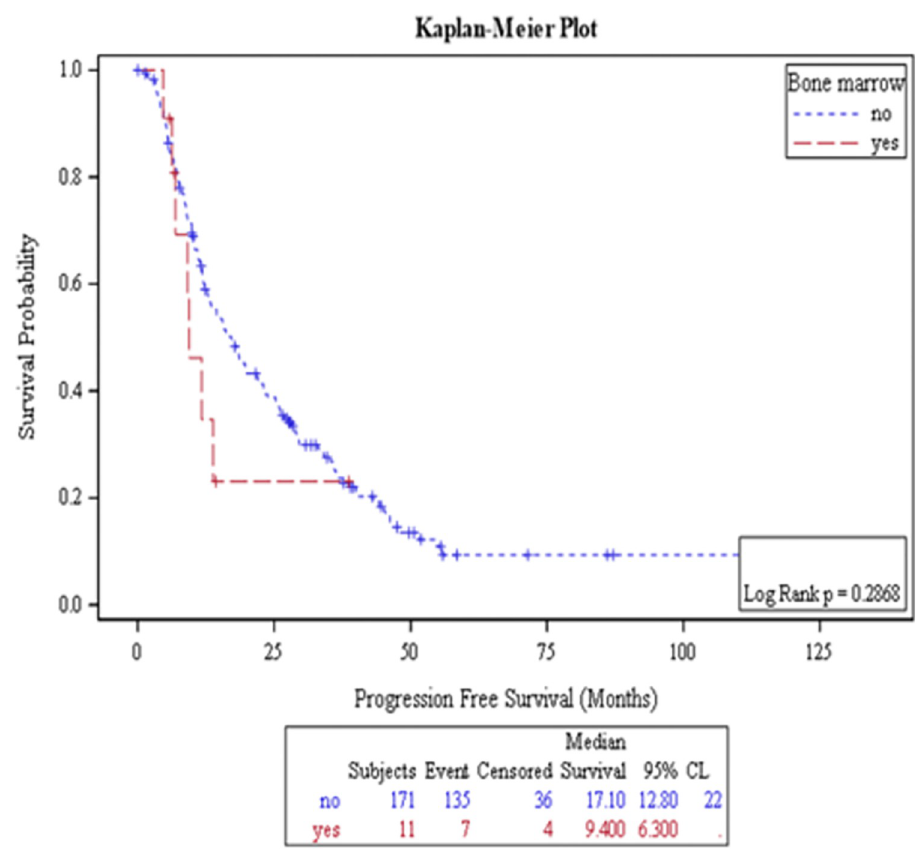
Fig 1. Kaplan-Meier estimation of time to PSA progression according to presence of bone marrow metastasis.